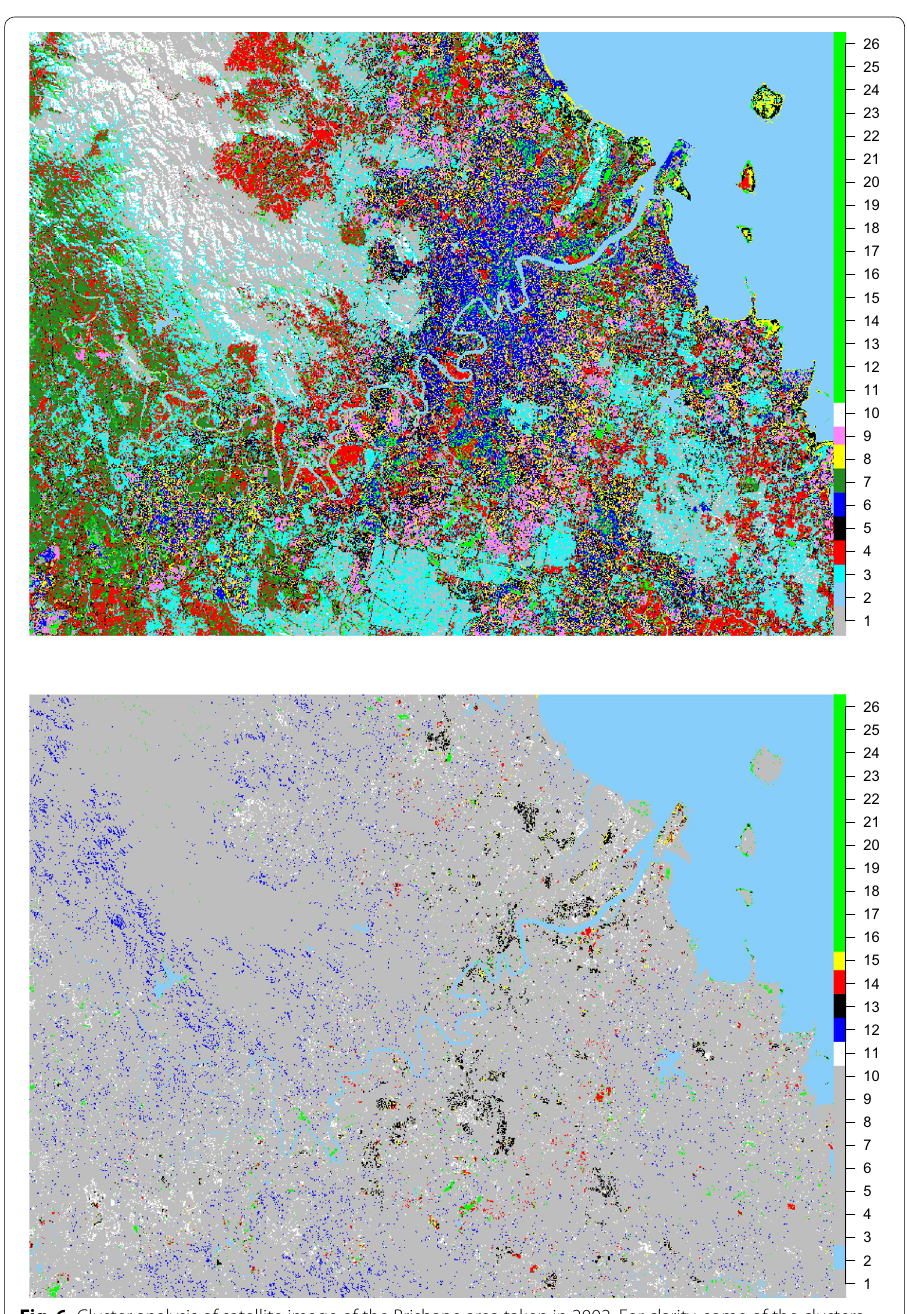
Fig. 6 Cluster analysis of satellite image of the Brisbane area taken in 2002. For clarity, some of the clusters are merged together in bright-green colour and the results are presented in two plots: (left penal) 1: mountains and forest, 2: water, 3: forest 4: mix of parks, playgrounds and grassland, 5: old residential areas including some roads, 6: old residential areas, 7: scrub-land, 8: Bright surfaces including seashore, 9: new residential areas, and 10: mountains and forest; (right penal) 11: parks and playgrounds, 12: mountains and forest, 13: commercial buildings, 14: disturbed earth (recent deforestation), 15: impervious